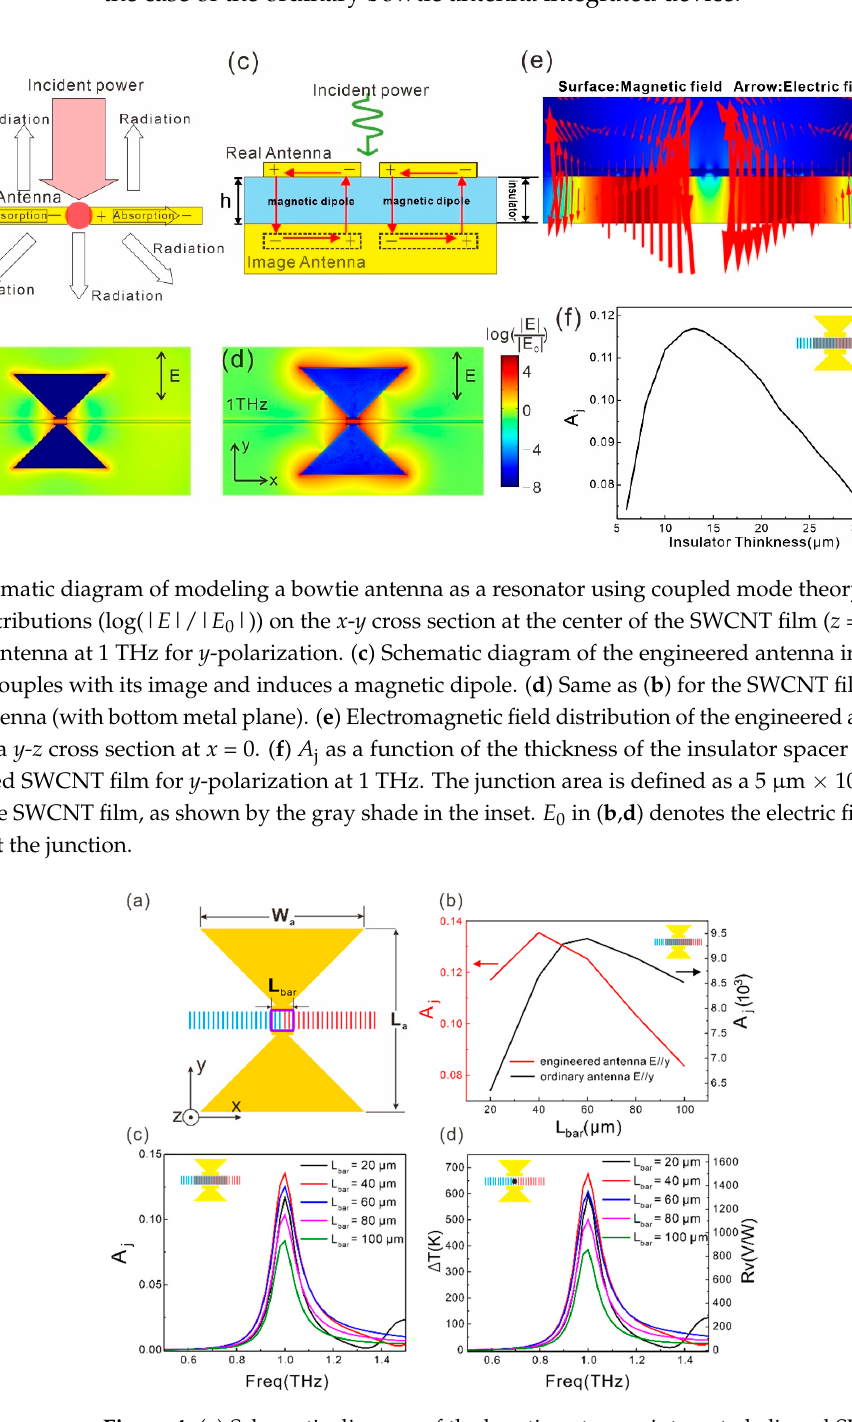
Figure 4. ( a ) Schematic diagram of the bowtie antennas integrated aligned SWCNT film. The purple region represents the part of the SWCNT film between the two extension bars. R load is decided by the SWCNTs within this region. ( b ) A j as a function of L bar for y -polarized incident light at 1 THz. Black line: ordinary antenna integrated aligned SWCNT film; Red line: engineered antenna integrated aligned SWCNT film. ( c ) Spectra of A j at different L bar for the engineered antenna integrated